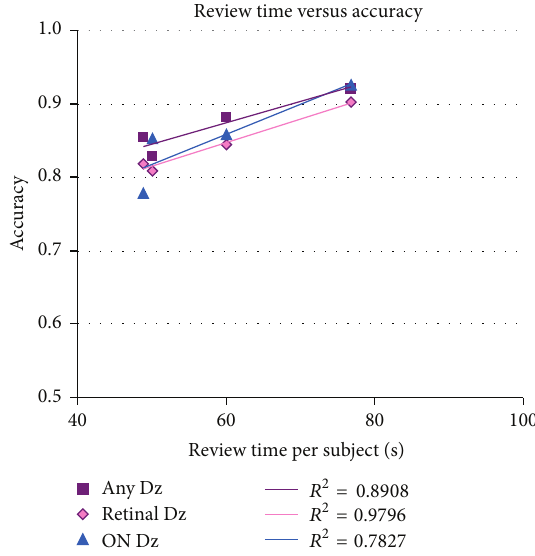
Figure 8: Amount of time novices spent reviewing images is compared with the accuracy of their